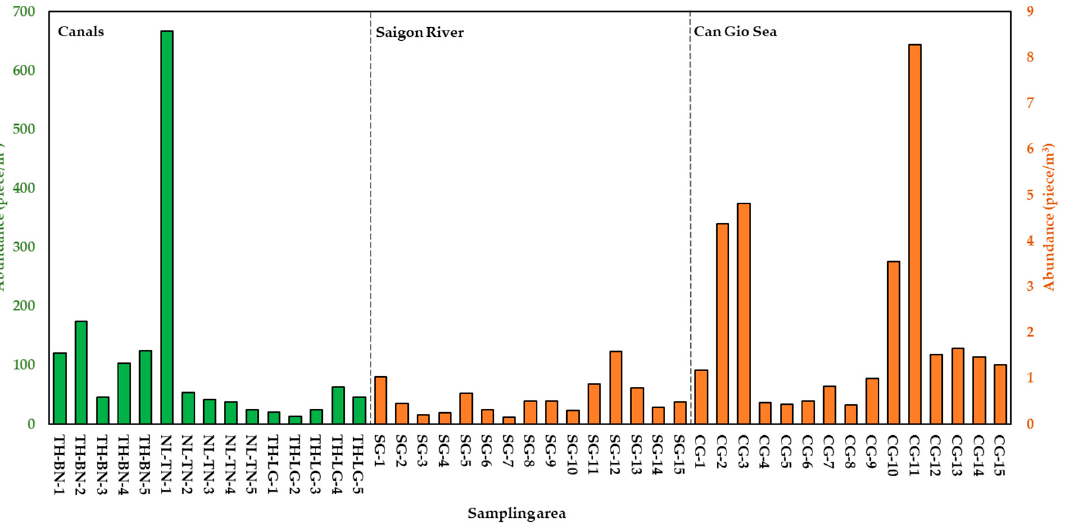
Figure 2. Abundance of MPs in canal systems, Saigon River, and Can Gio Sea in HCMC, Vietnam, in August 2020.